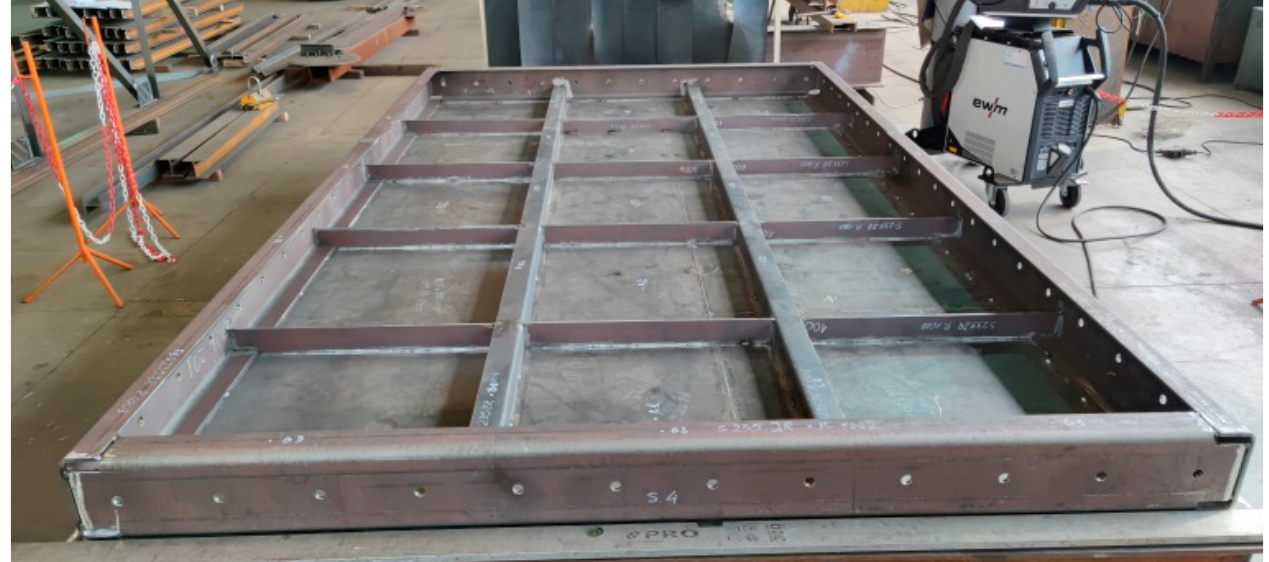
Figure 1. Furnace wall panel elements connected by spot welds. For the numerical simulation of the stress and strain distribution, a CAD and FEM model of the industrial furnace wall panel was created (Figure 2).